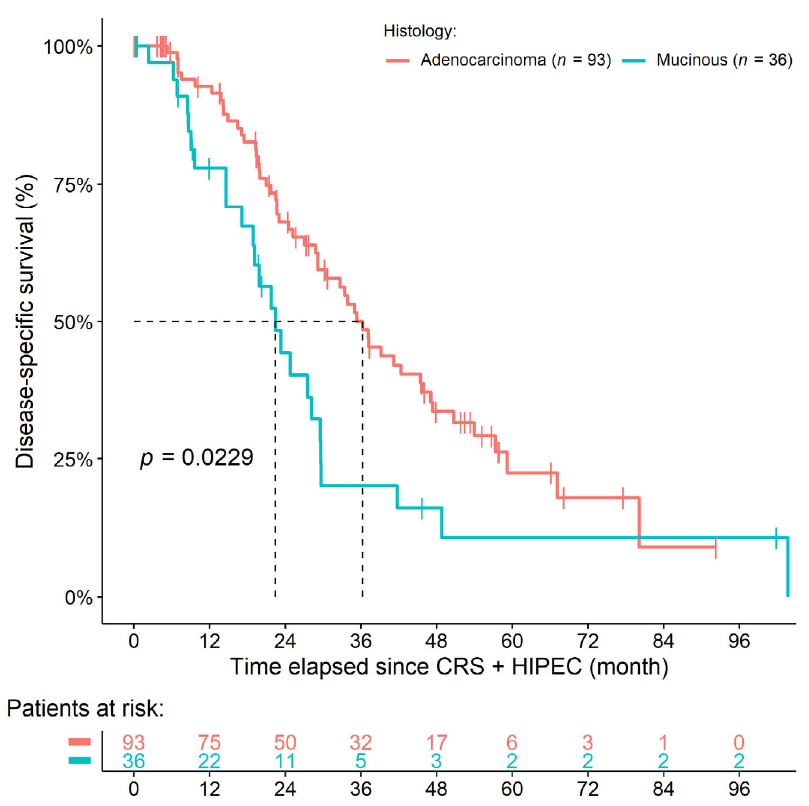
Figure 1. Survival curves of colorectal cancer patients with synchronous peritoneal metastasis. The histological diagnosis of mucinous adenocarcinoma was associated with inferior